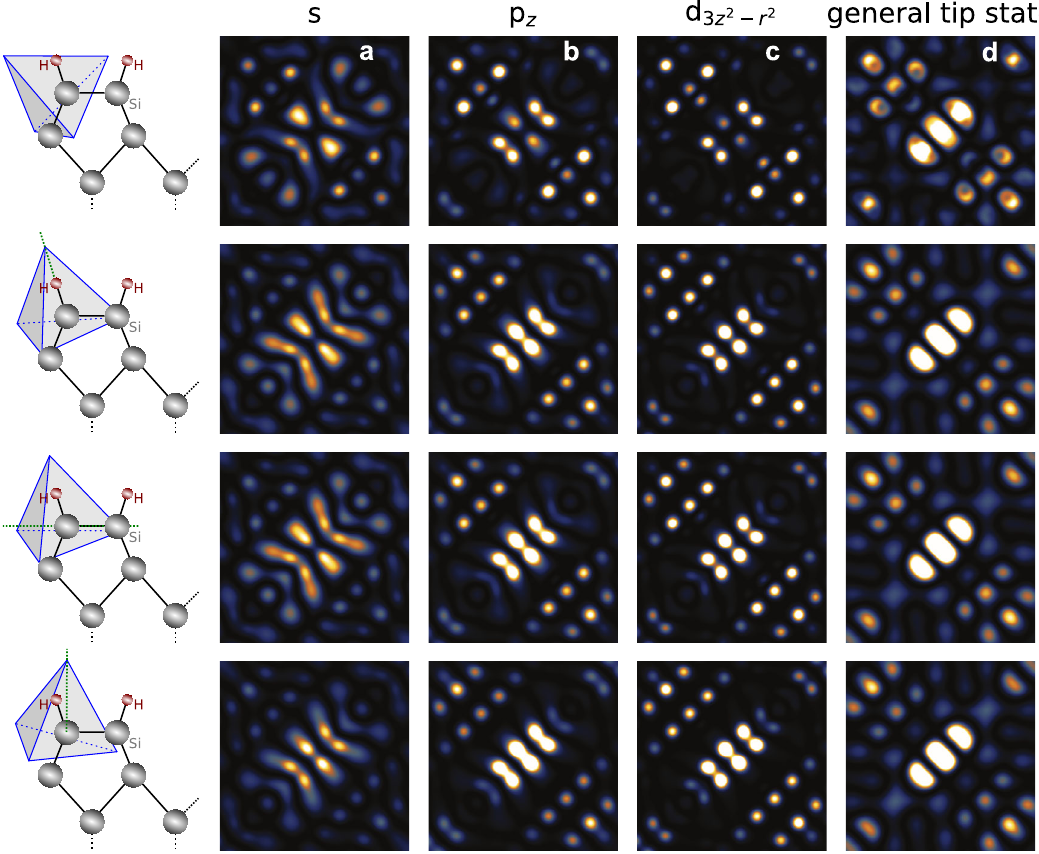
Fig. 9 A study of simulated STM images for implicit passivation scheme with a 2.5 eV energy shift. Each column is generated with a different tip state, while each row corresponds to a different orientation of the assumed ideal tetrahedron formed by bond directions: a without rotation (same as in the unstrained crystal), b rotated according to the direction to hydrogen atoms, c rotated according to the dimer bond and d rotated in a way that adjusts the dangling bond in the [001] direction. Despite the general tip state used in the right-most column being individually fi tted to each image, none of them is able to fully capture the features in P-1-Th image (see the